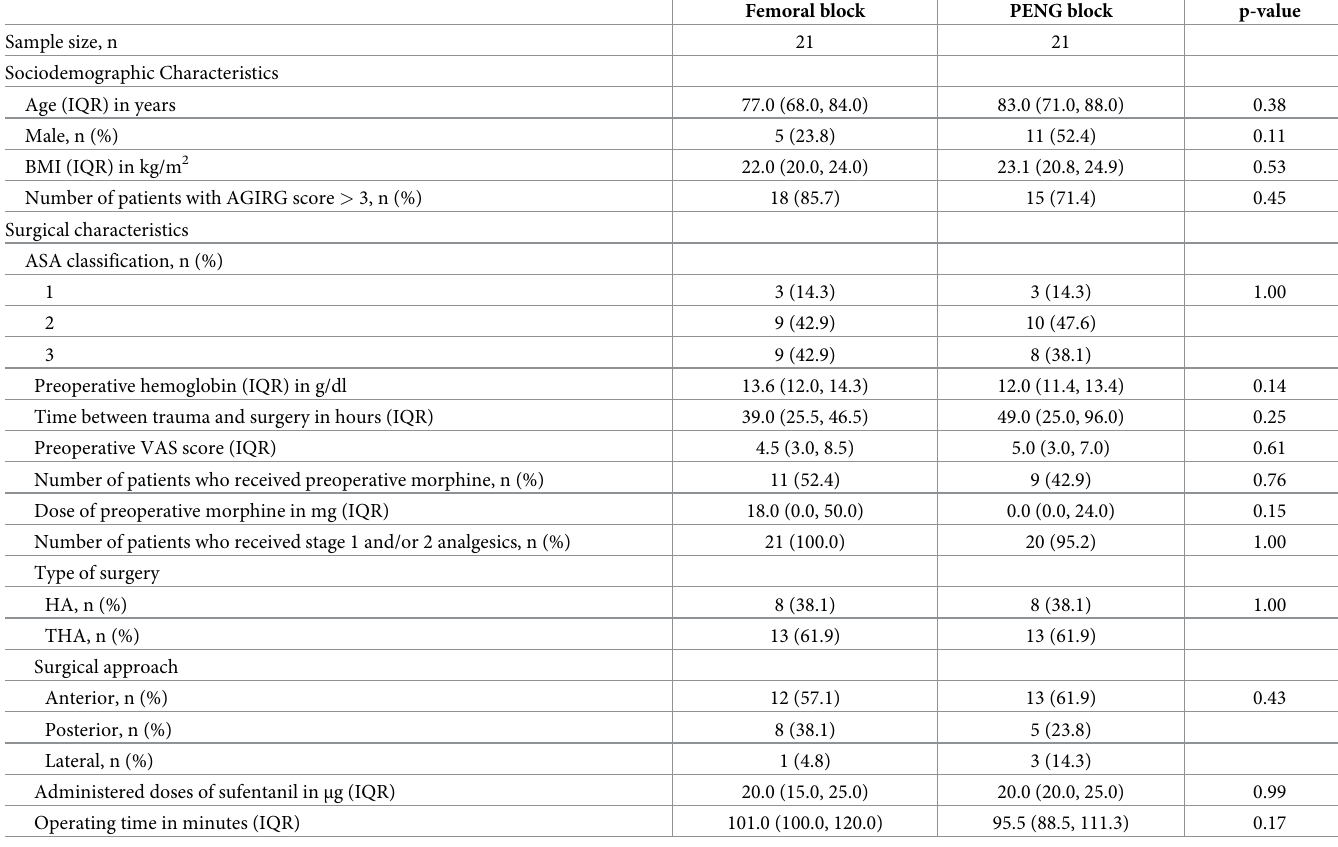
Table 1. Patients demographics and surgical characteristics of patients in both